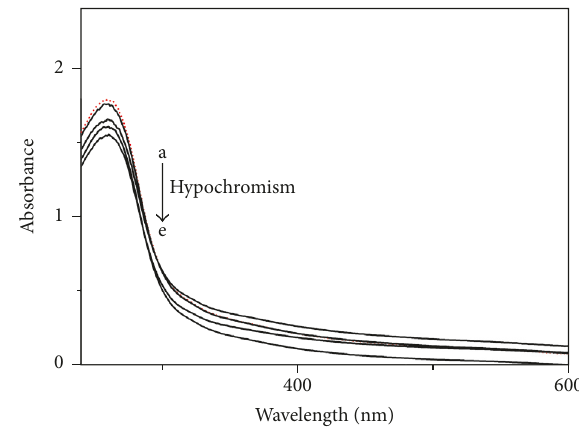
Figure 7: Absorption spectra of complex 1 with CT-DNA in Tris- HCl